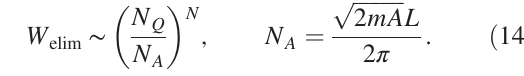
FIG. 5. (a)Weplottheintensityoftheoff-diagonalmatrixelementsof quench of the c ¼ 1 gas discussed in Fig. 3(c). (c) We plot the average size of the off-diagonal matrix elements of two sequences of effective charges Q ð N Q Þ ; in black is the sequence constructed from m ¼ 9 ; … ; 16 .Weshowthisforboththe c ¼ 1 [samequenchasin(a)and(b)]andthe c ¼ 10 case[samequenchasdescribedinFigs.3(a) –